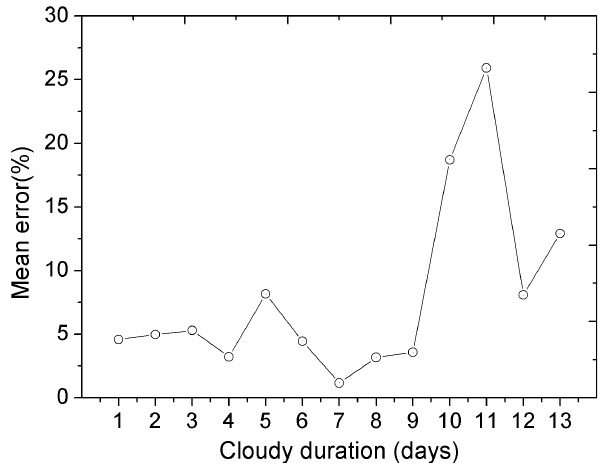
Fig. 2. Mean error between the interpolation and the observed snow cover fraction for increasing